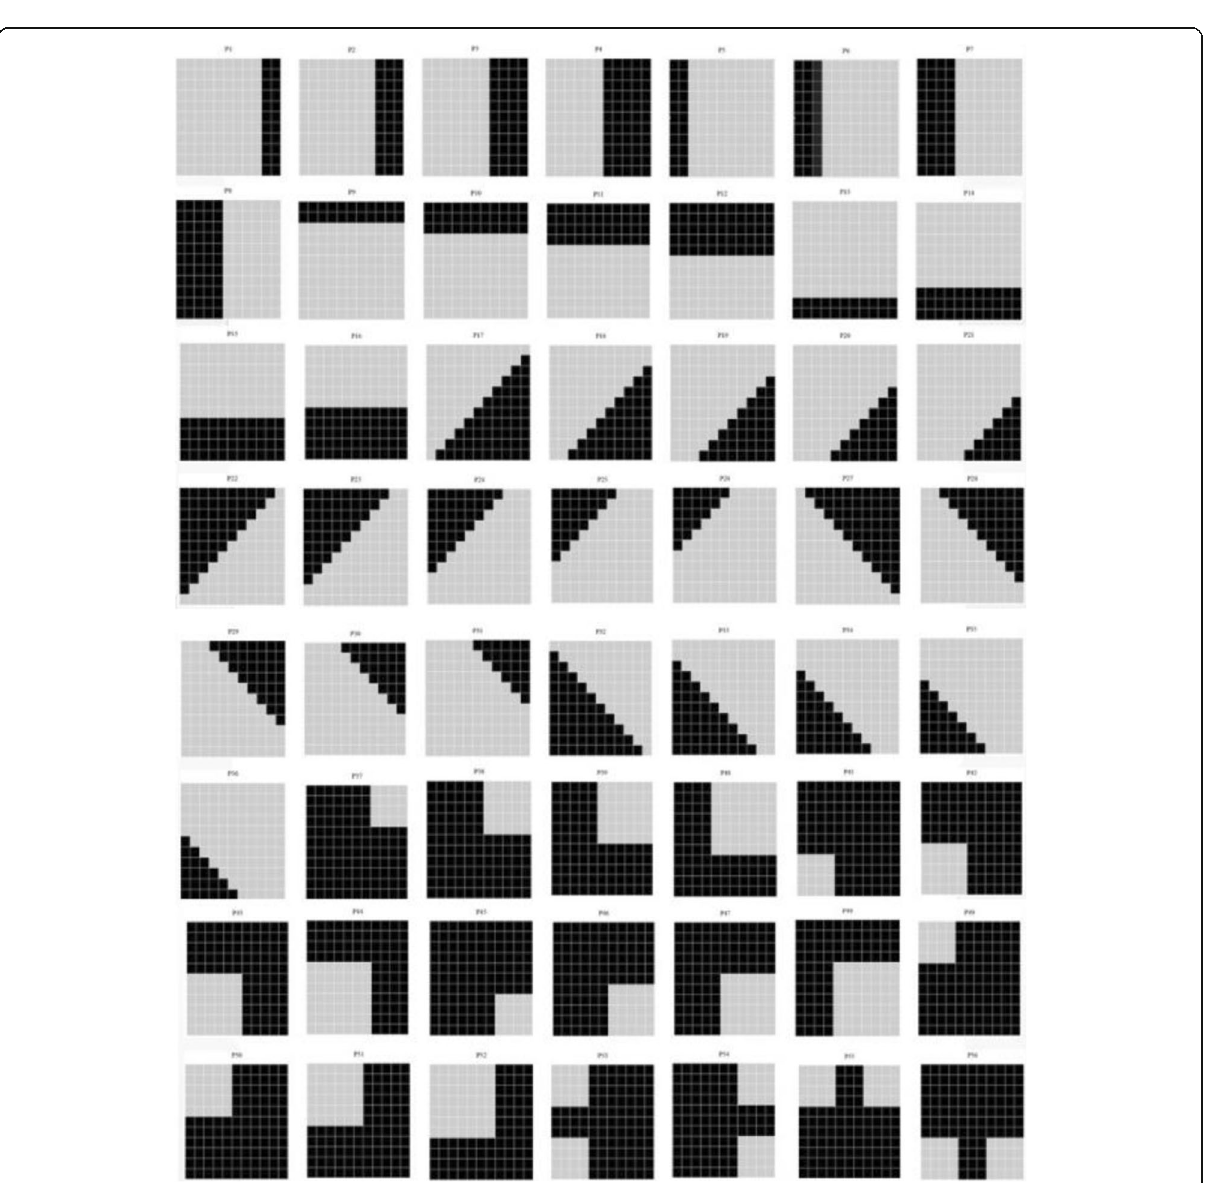
Fig. 2 Binary molds for image and depth block